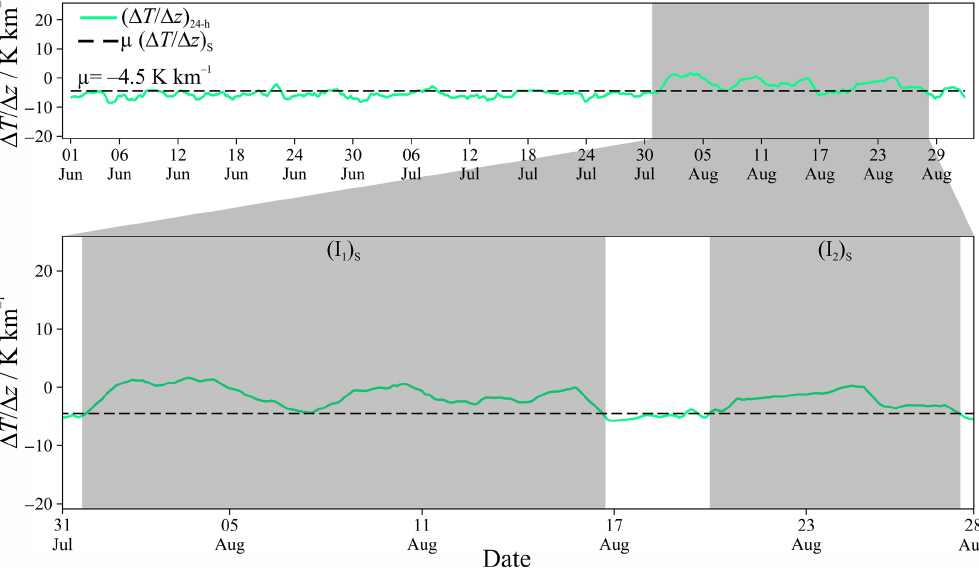
Figure 11. The 24h running mean of the pseudo-vertical temperature gradient in summer; two persistent temperature inversion events (I i ) S detected by the TGM are shown in the shaded section and enlarged in the breakout panel beneath; see text in Sect. 2.3.2 for details.